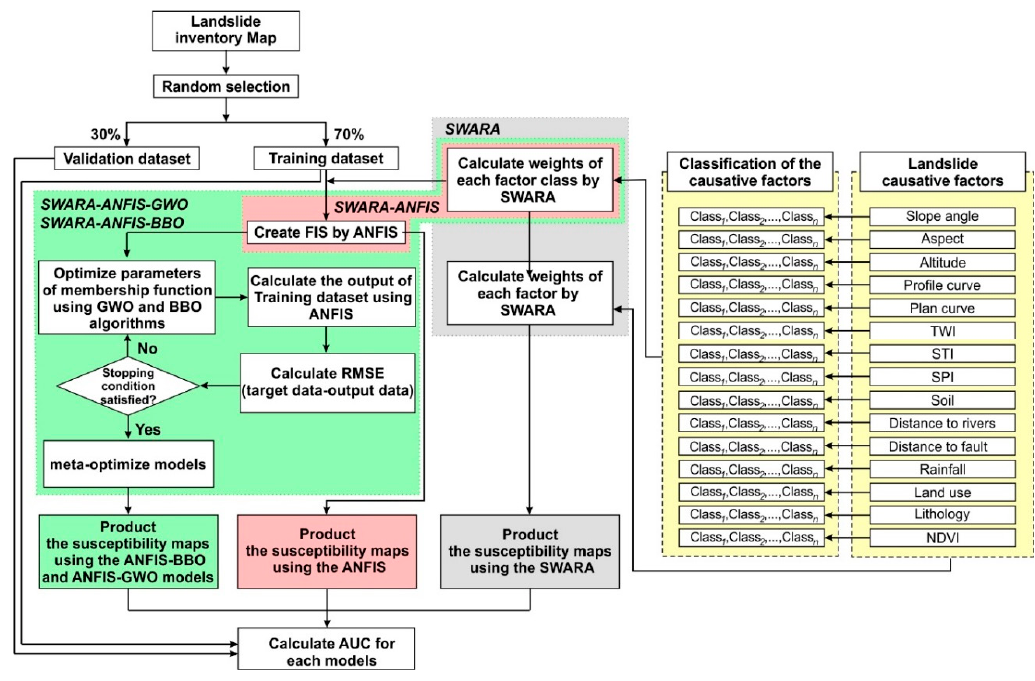
Figure 4. Flowchart of the proposed framework.